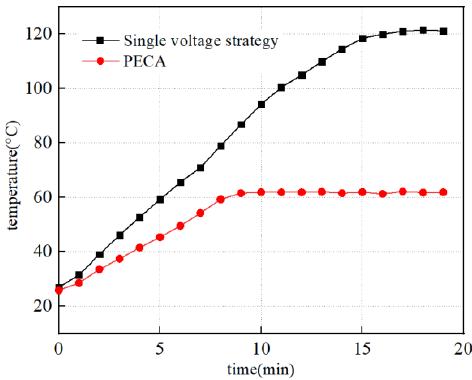
Figure 11. The temperature rise curve in two driven strategies.